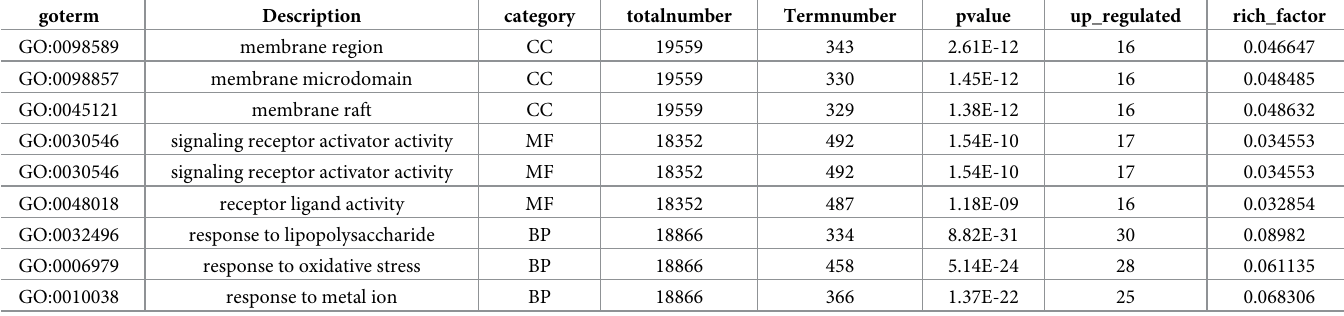
Table 2. Example of go-pathway enrichment circular diagram.